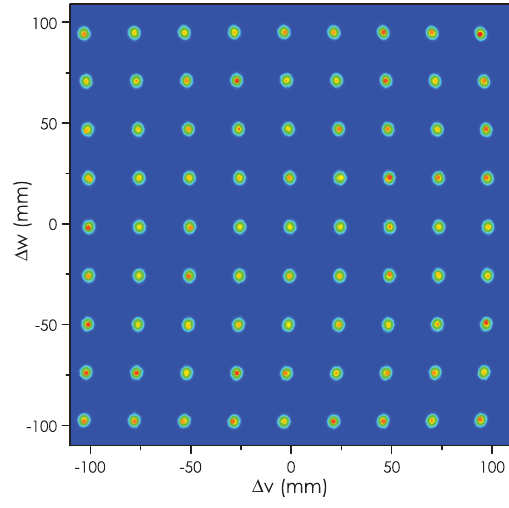
∆ FIG. 18. Beam profile at the isocenter, as calculated with track- ing simulations. Each of the beam spots consisted of 5000 parti- cles, and the 81 spots correspond to the beam with the maximum kicks of SCM-X and SCM-Y to be (cid:1) 18 and (cid:1) 21 mrad , respec- tively, as multiplied by 0, 0.25, 0.75, or 1.0. In the simulations, the field map for the coil currents of 231.2 A was used, and the corresponding beam energy is E ¼ 430 : 96 MeV =u .